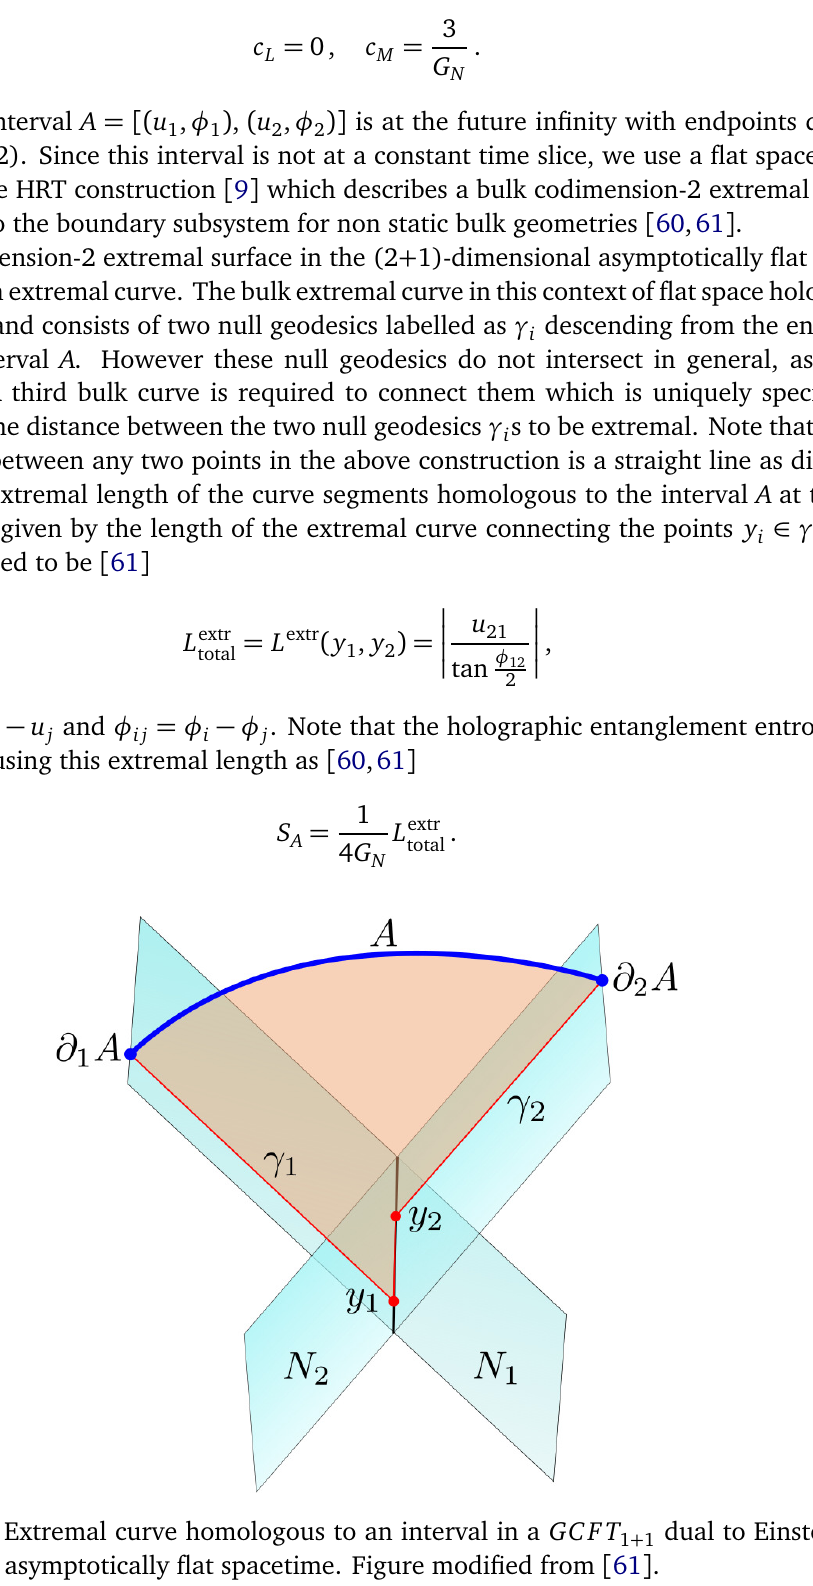
dual to Einstein 1 + 1